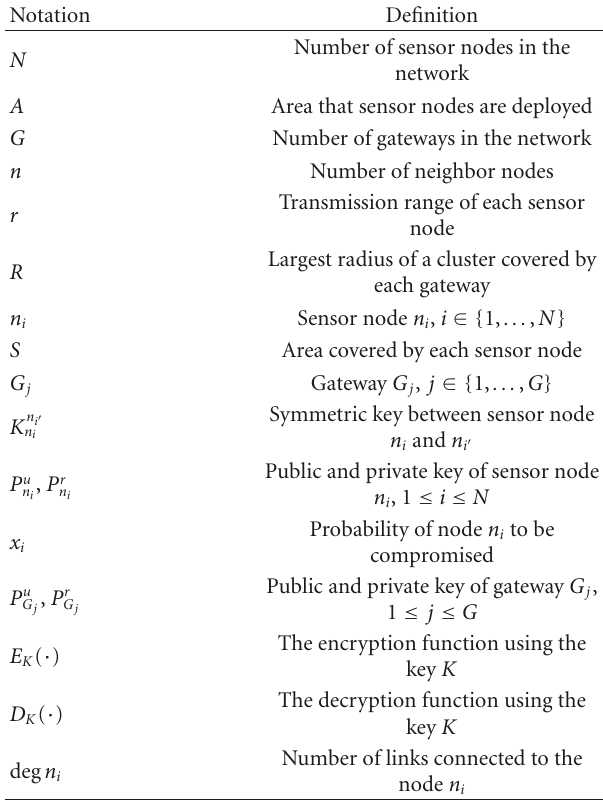
Table 1: Notations and their